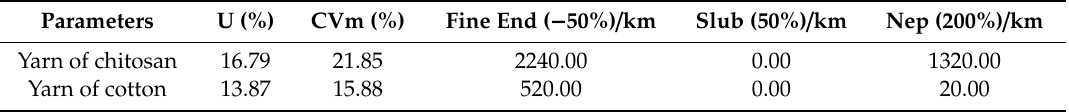
Table 2. The evenness of chitosan yarn.